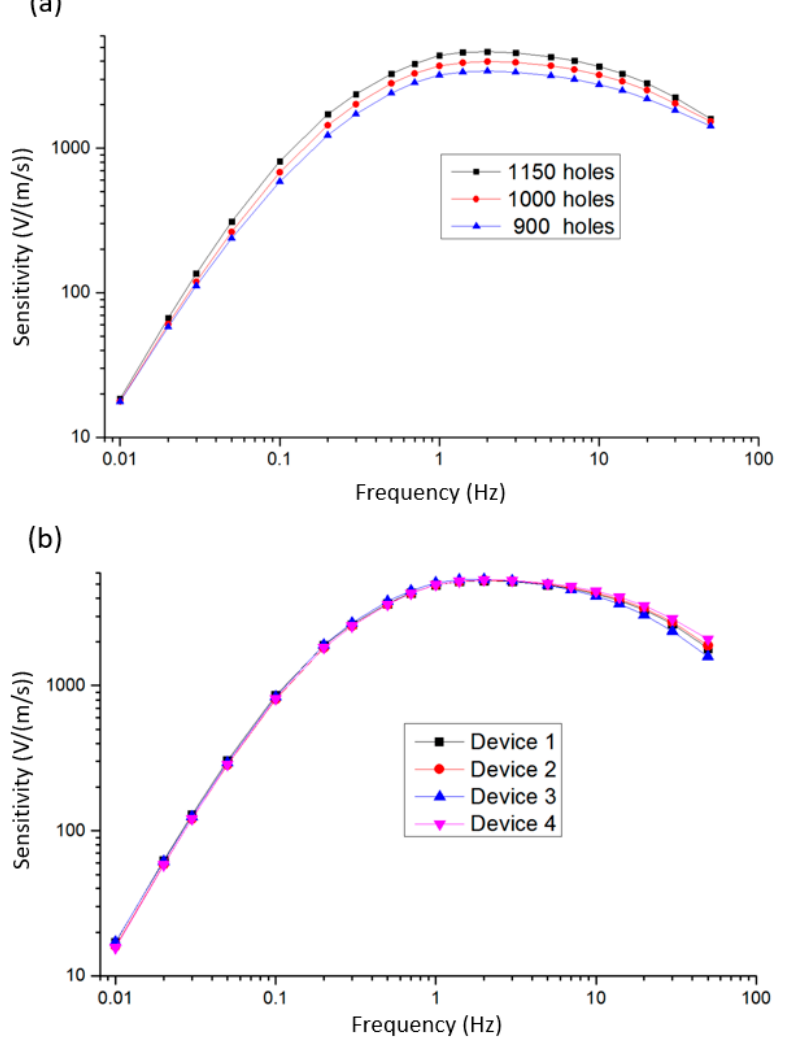
Figure 6. ( a ) The test results (sensitivity vs. input vibration frequency) of the fabricated electrochemical seismometers with 1150, 1000 and 900 flow holes, respectively. ( b ) The sensitivity curves with mean and standard deviation of four devices with 1150 flow holes.